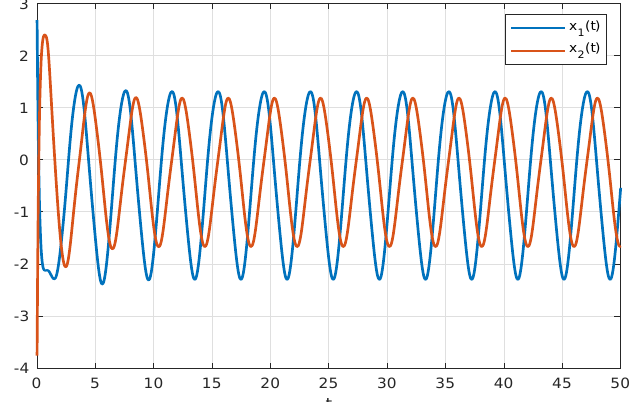
Figure 5. State trajectories of INNs (21) without any control input.